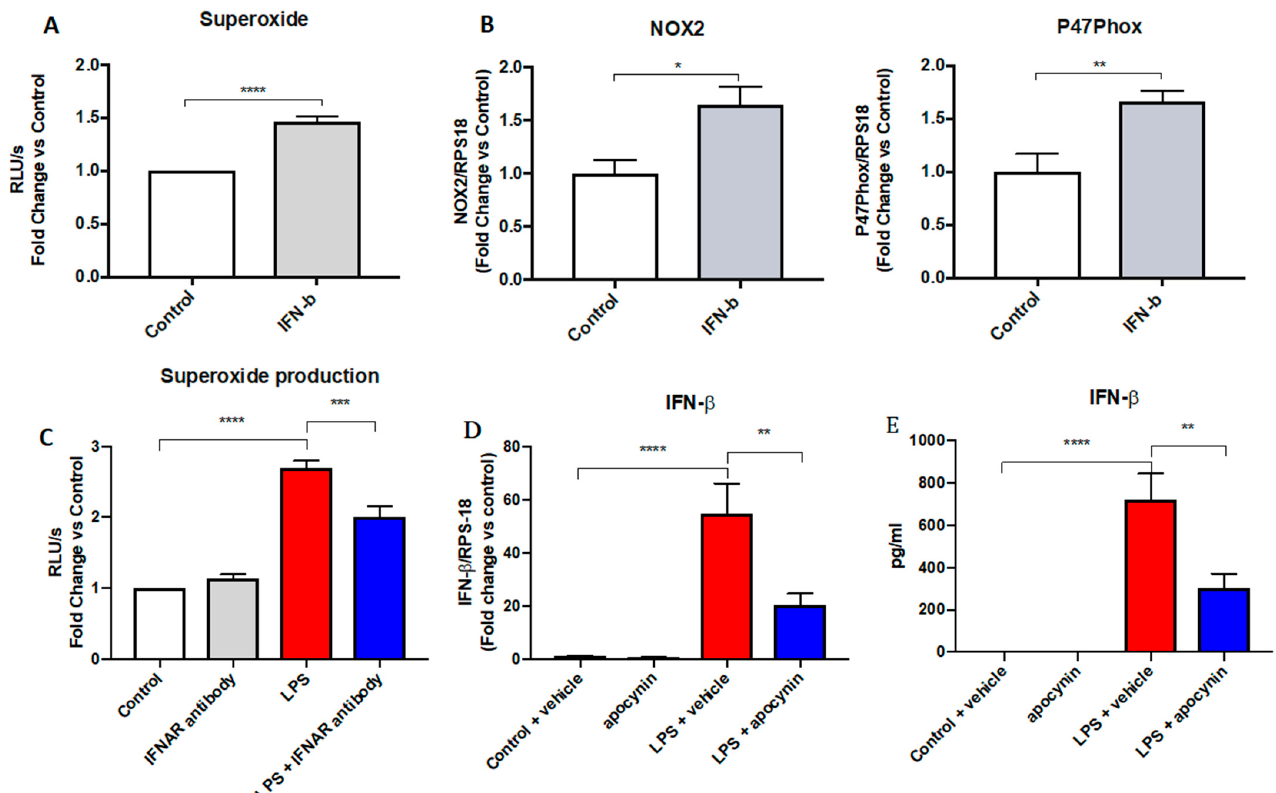
Figure 5. IFN- β is involved in an intricate feedforward loop by increasing the NOX2-dependent oxidative burst. ( A – C ) RAW 264.7 cells following 24 h treatment of recombinant IFN- β (100 ng/mL) measuring; ( A , C ) oxidative burst measured by L-012-enhanced chemiluminescence, ( B ) mRNA expression measured using qPCR; ( D , E ) RAW 264.7 cells pre-treated with apocynin (300 μ M) followed by 24 h treatment of LPS (100 ng/mL). Data are presented as mean ± SEM of n = 4–8 experiments. Data are expressed as ( A , D ) fold change vs. control relative to the housekeeping gene RPS18 and ( B ) relative light units (RLU), measured as an average of triplicates over a 60-cycle period, subtracted by blank readings or the fold change against the vehicle control of a peak response over an average of triplicates over the 60-cycle period, subtracted by blank readings, ( C ) Fold change vs. control relative to the housekeeping protein β -actin, and E) in pg/mL. Statistical analysis was conducted using ( A – C ) an unpaired Student’s t -test, or ( D , E ) a one-way ANOVA followed by Tukey’s post hoc test for multiple comparisons. * indicates p < 0.05, ** indicates p < 0.01, *** indicates p < 0.001 and **** indicates p < 0.0001.